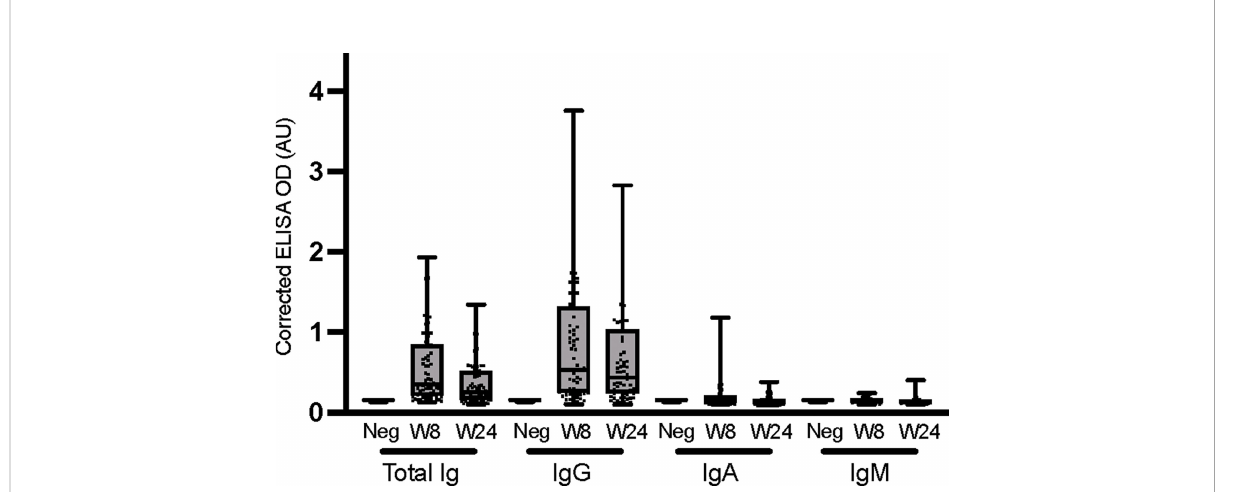
FIGURE 4 Isotyping of anti-nucleocapsid immunoglobulins. ELISAs were conducted at the UdeM site to determine total Ig, IgG, IgA and IgM against the nucleocapsid (NC) antigen at weeks 8 and 24. Serum samples exclude those of individuals who were vaccinated during the study and include W8: n = 65 and W24: n = 67 individuals. The secondary antibodies used are listed in Table 2. The average of triplicate assays is given as corrected OD. The median is shown in the quartile boxplots where the whiskers include all values (no outliers excluded). Negative controls using serum from 8 COVID-negative individuals are given as the average of triplicate assays. Results for the seroconversion ROC analyses for these datasets are presented in Supplementary Table